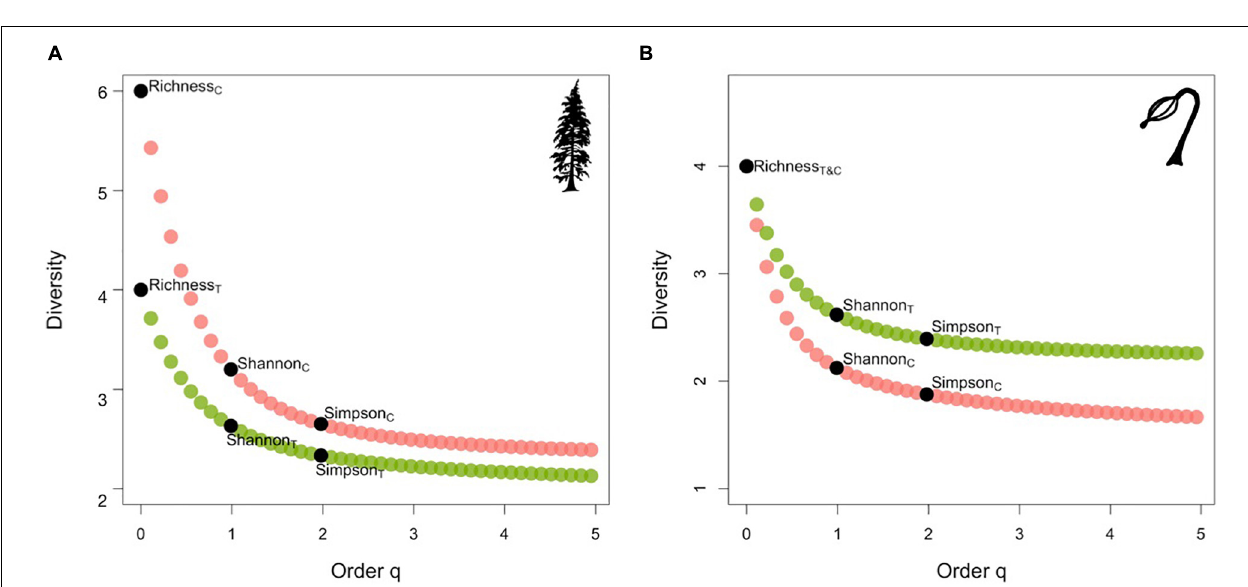
FIGURE 2 | Diversity profile curves plotting habitation (green) and control (pink) sites species diversity as a function of order q -values for (A) adult tree communities, and (B) regeneration communities. The black dots denote Hill numbers: species richness ( q = 0), Shannon diversity ( q = 1), Simpson inverse diversity ( q = 2). Curve slope reflects evenness of relative species abundances (e.g., the steeper the curve the more uneven the distribution of relative abundances).